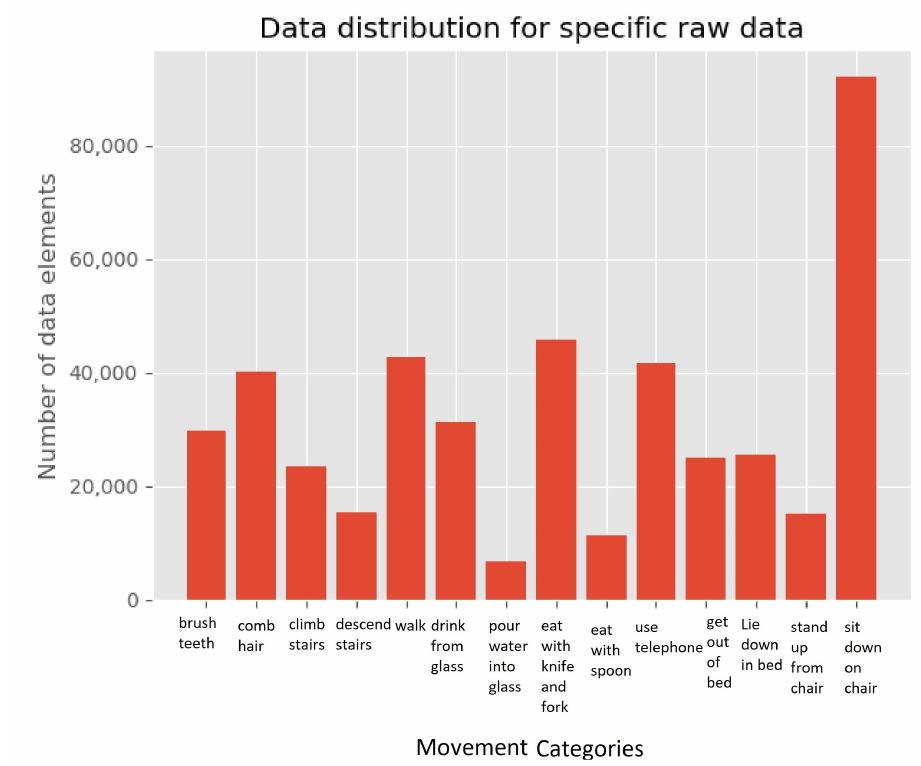
Figure 3. Specific raw data distribution for the wrist-worn